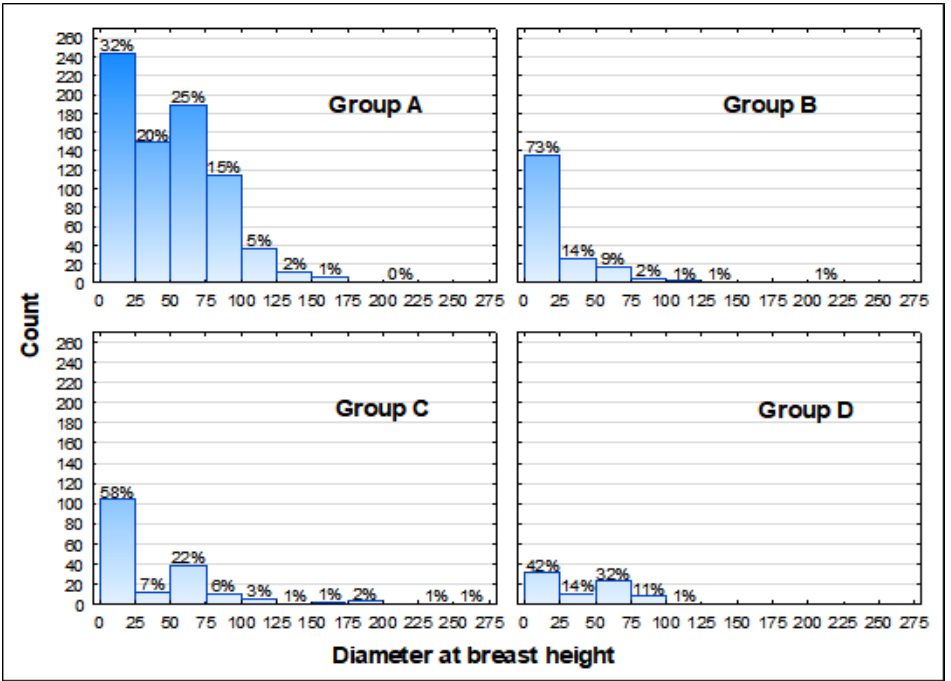
Figure 9. Histograms of diameter at breast height (DBH) structure of the inventoried groups. Group A is the Jabal Samhan population, B and C are populations located at the eastern parts of Jabal al Qamar, and group D is located at the western part of Jabal al Qamar. Forests 2019 , 10 , x FOR PEER REVIEW